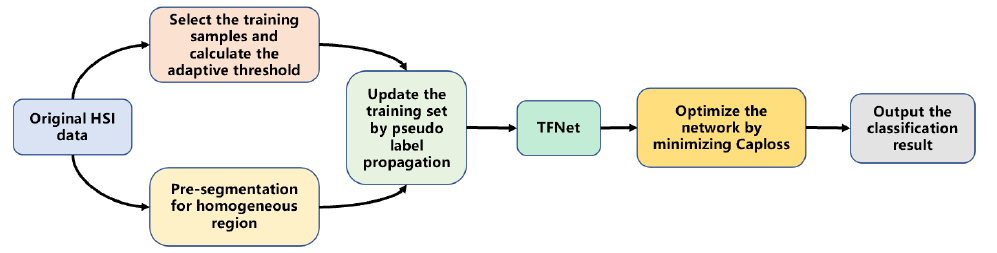
Figure 1. The overall flowchart of the proposed